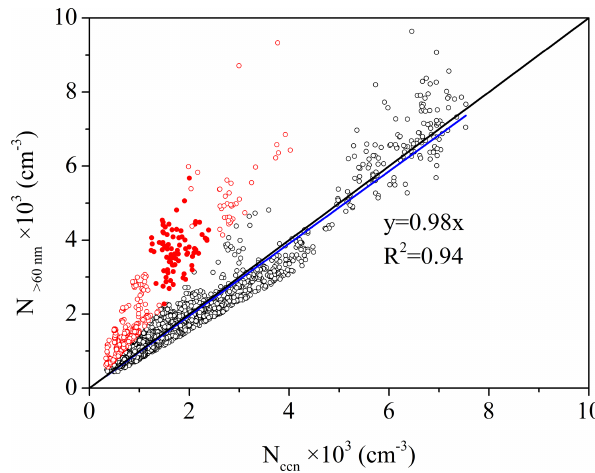
Figure 3. Scatterplots of N ccn at SS of 0.4% versus N > 60nm (BB and dust aerosols are shown in full red cycles with empty red cy- cles representing either suspected BB or suspected dust aerosols; the black line represents the 1 : 1 relationship, and the blue line shows the best fit using the data shown as black empty